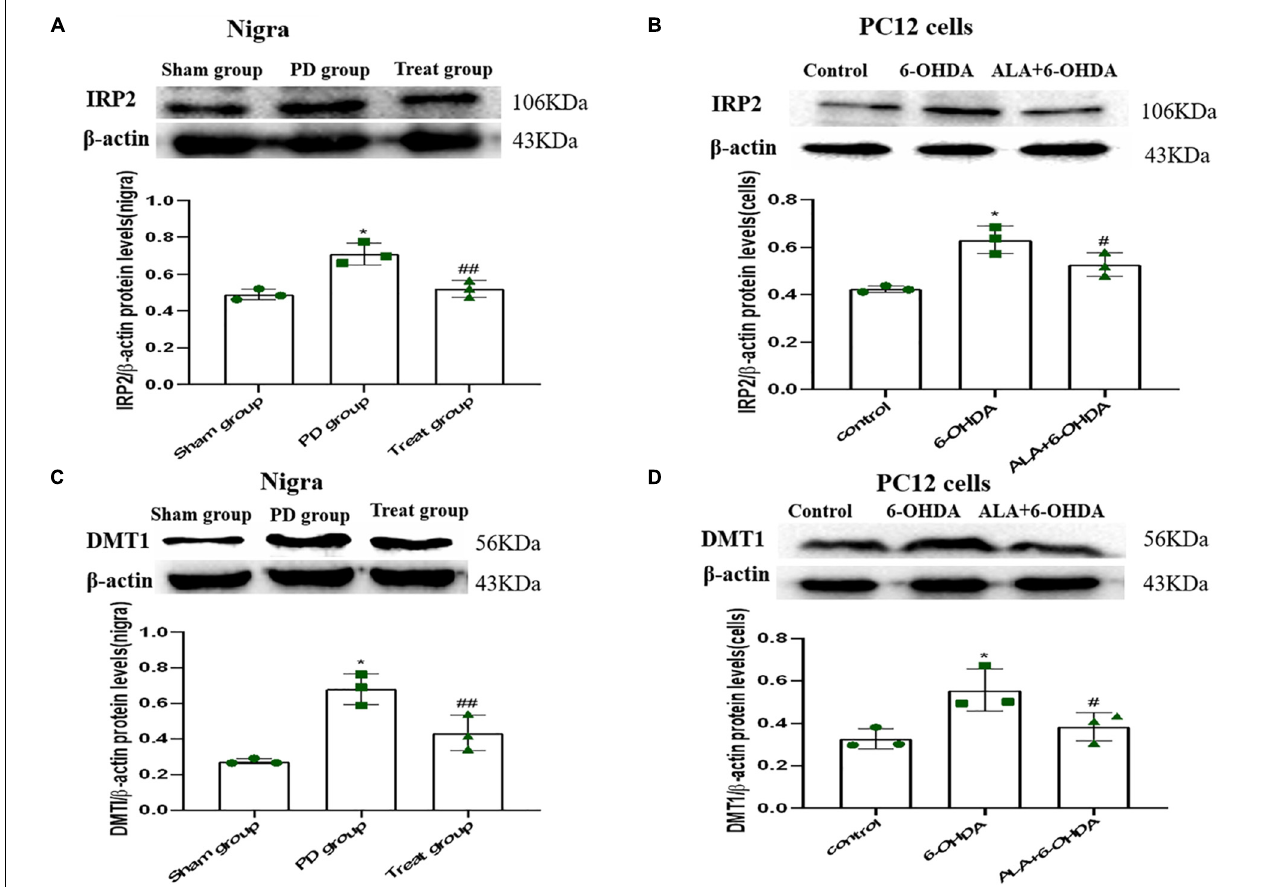
FIGURE 6 | ALA suppresses the 6-OHDA-induced upregulation of DMT1 via IRP2 in the SN of rats and PC12 cells. Rats and cells were treated with 6-OHDA and ALA, as described in section “Materials and methods.” The iron metabolism-related protein levels of IRP2 (A,B) and DMT1 (C,D) in rat SN and PC12 cells were detected by western blot. Data were expressed as the means ± SD analyzed by one-way ANOVA ( n = 3). Statistical significance: * P < 0.01 vs. sham group or control; ## P < 0.01, # P < 0.05 vs. PD group or